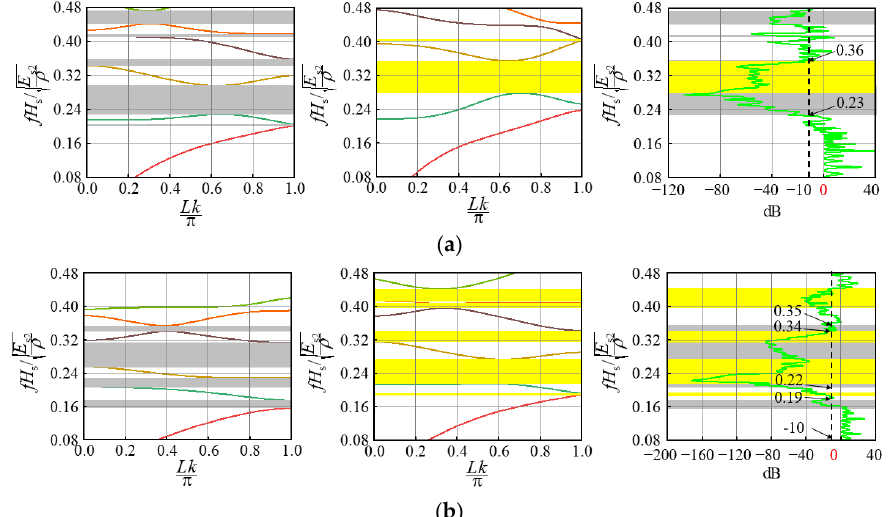
Figure 8. Influence of modulus ratio E f / E s on the band gap: ( a ) 2.3 and 1.0; ( b ) 12.0 and 4.0. buckling morphology changes, the width of the band gap remains unchanged, but the frequency shifts down as a whole, so it is beneficial to the adjustment of the band gap. In